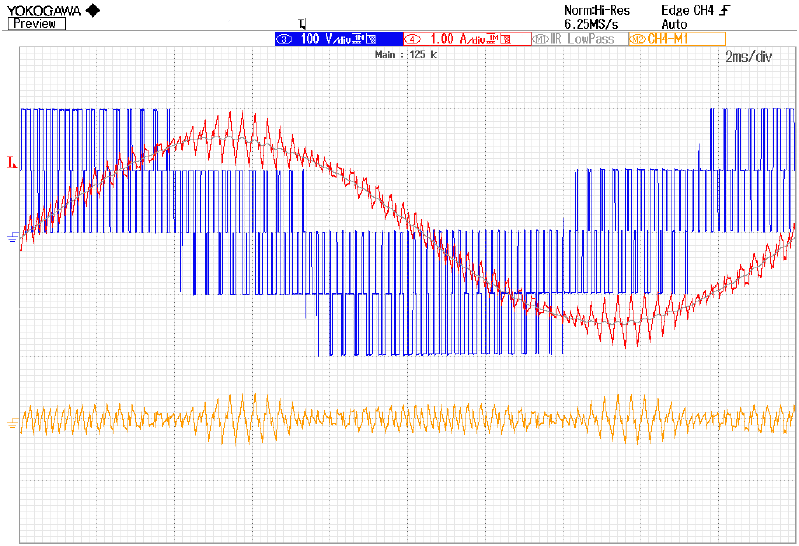
Figure 7. Details of experimentally obtained line-to-neutral voltage (blue trace), instantaneous current (red trace), fundamental current (grey trace), and current ripple (orange trace) for the 2.2 kW IM supplied by a three-phase inverter (centered PWM): V dc = 300 V, f sw = 3 kHz and m = 0.5.